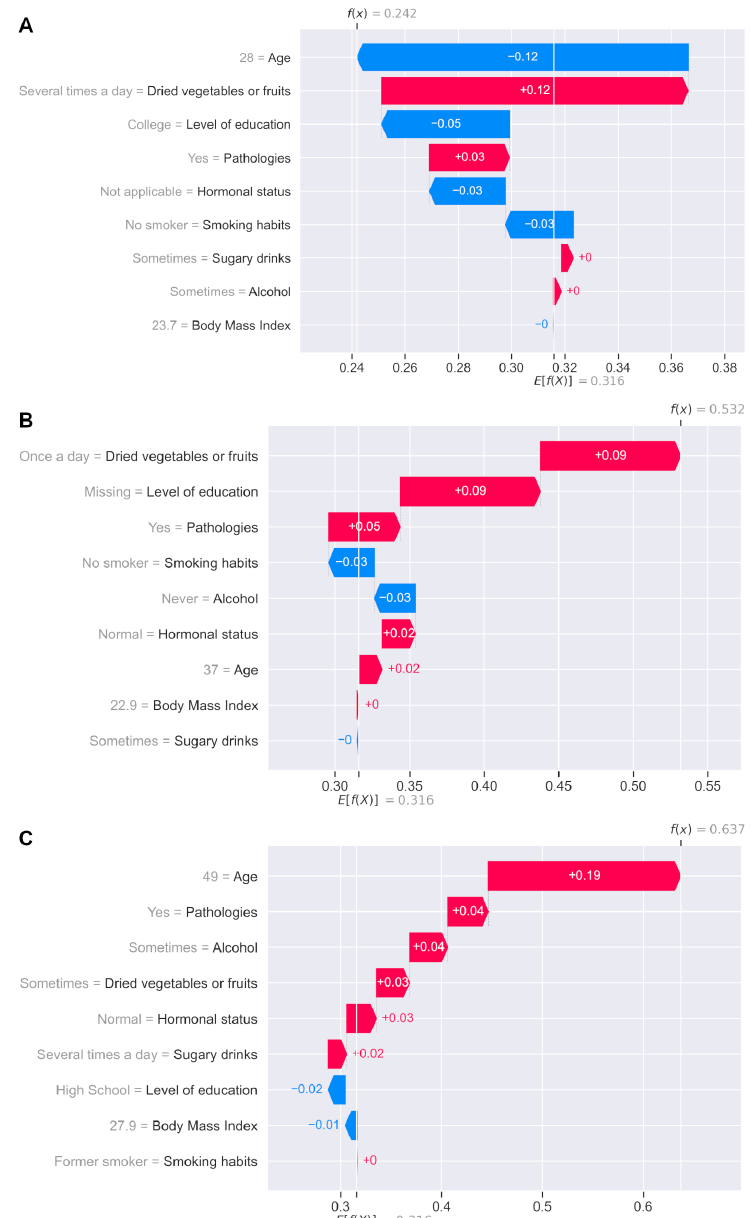
Figure 7. Explanations at the individual level (individual risk prediction). ( A ) A 28-year-old healthy subject predicted to have a 0.24 probability of periodontitis. ( B ) A 37-year-old healthy subject with a 0.53 probability of periodontitis. ( C ) A 49-year-old subject presenting periodontitis-accumulating risk factors and predicted to have a high risk of periodontitis